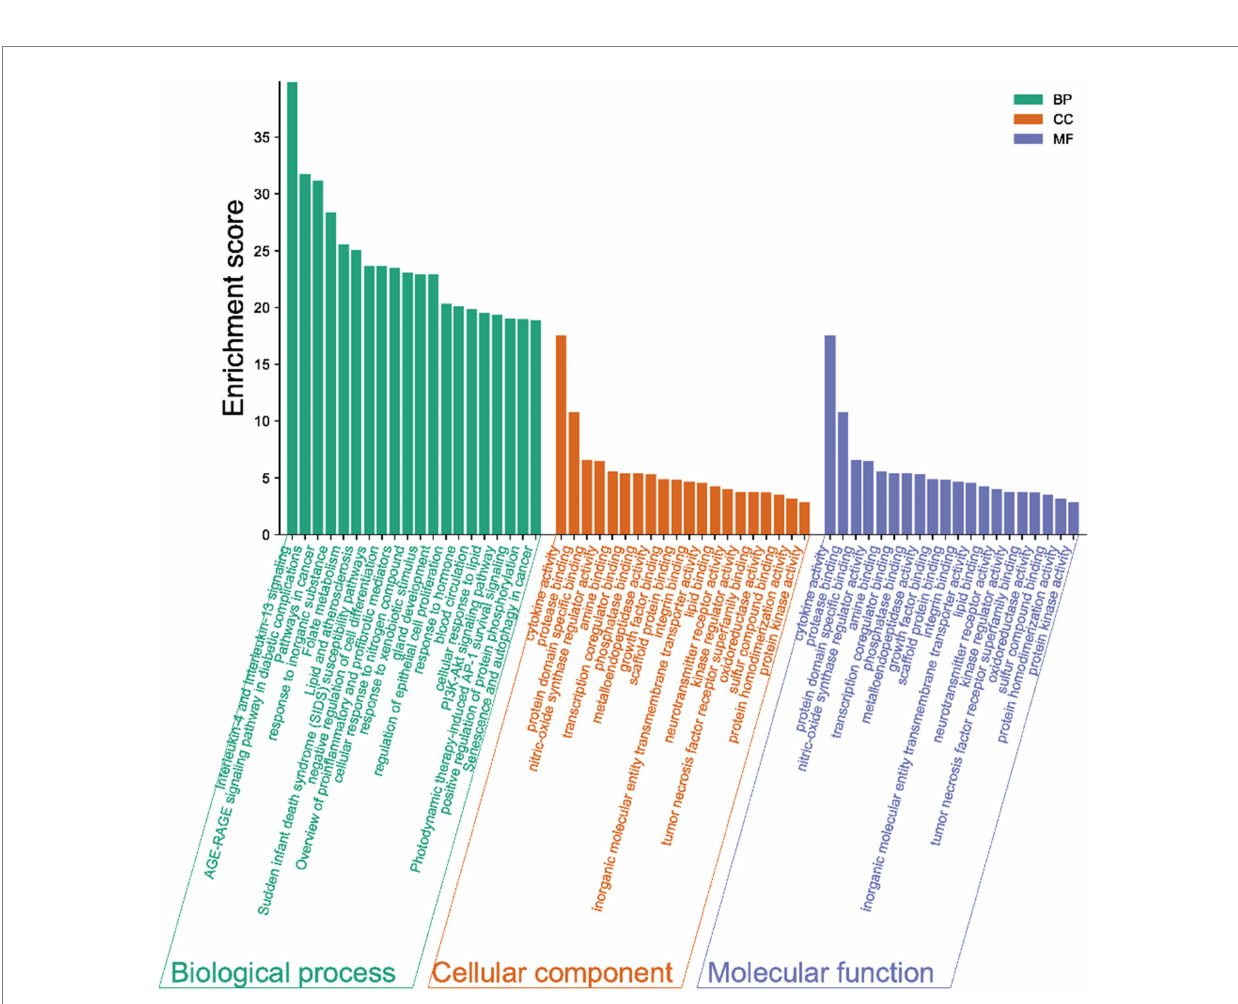
FIGURE 4 Gene ontology (GO) terms. The green bars represent the biological processes (BPs), while the orange refers to the cellular components (CCs), and the blue shows the molecular functions (MFs) of the genes. The vertical axis is the enrichment